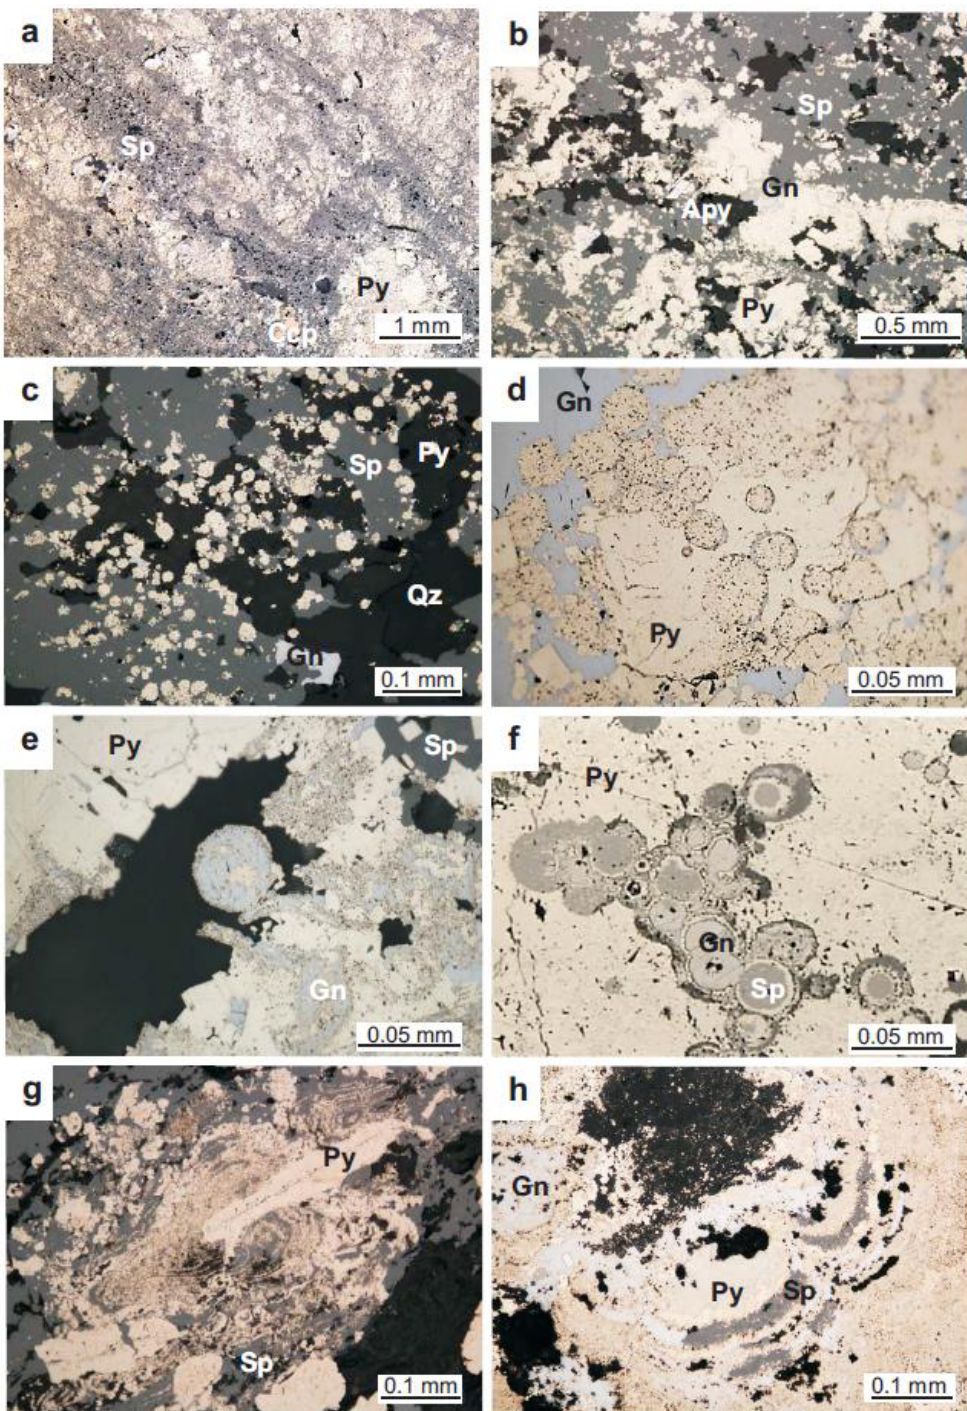
Figure 6. Optical microscope images of polymetallic mineralizations from several massive sulfide deposits of the IPB. ( a ) pyrite (Py) banded textures partially replaced by sphalerite (Sp) along high porosity bands; ( b ) advanced replacement textures on banded pyrite by polymetallic sulfide ore; ( c ) framboidal pyrite relicts partially embedded in sphalerite; ( d ) framboidal pyrite recrystallized and replaced by galena (Gn); ( e ) galena pseudomorph generated by replacement of framboidal pyrite; ( f ) aggregates of framboidal pyrite replaced by a second pyrite generation and late galena and sphalerite filling and replacing framboids and other open spaces; ( g ) selective replacement of colloform pyrite by sphalerite and galena. Massa Valverde deposit ( a ), Magdalena deposit ( b , c , g , h ) and Frailes deposit ( d – f ).